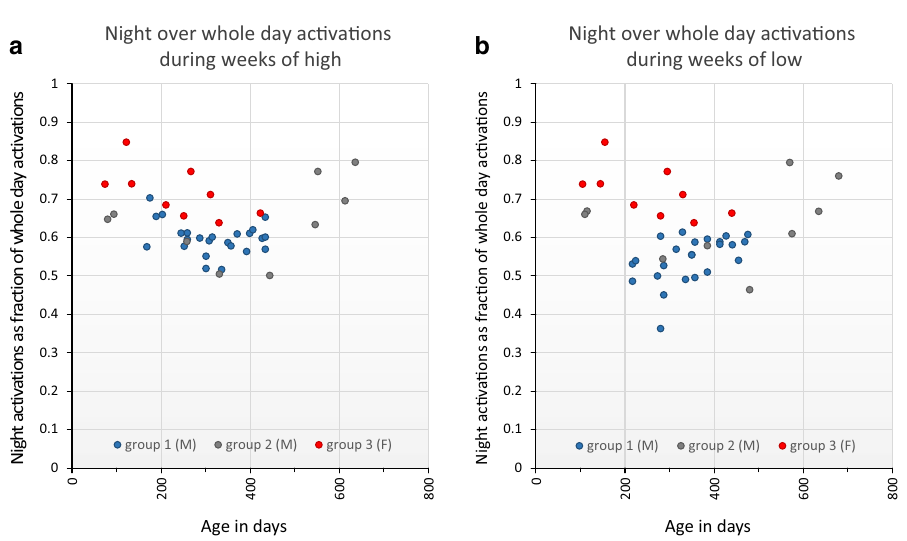
Figure 6. Plots of the fraction of the daily home-cage activity that occurs during the dark hours (night) over weeks with high (left panel ( a ); average 63%) or low (right panel ( b ); average 60%) level of home-cage activity, respectively. Ordinate is fraction of total daily activations occurring during the dark period and abscissa indicates age in days of the animals. The cumulative data records covers 434 days for group 1, 426 days for group 3, and 565 days for group 2. Key to cohort group at the bottom of the